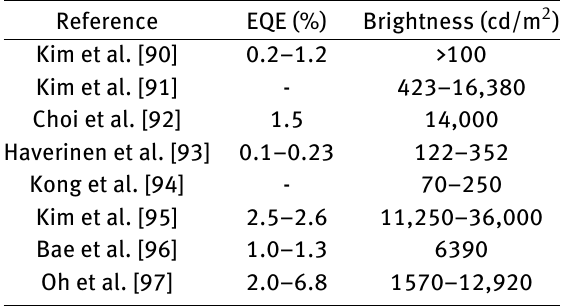
Table 3: External quantum eflciency (EQE) and brightness values of the quantum dot based electroluminescent displays covered in this